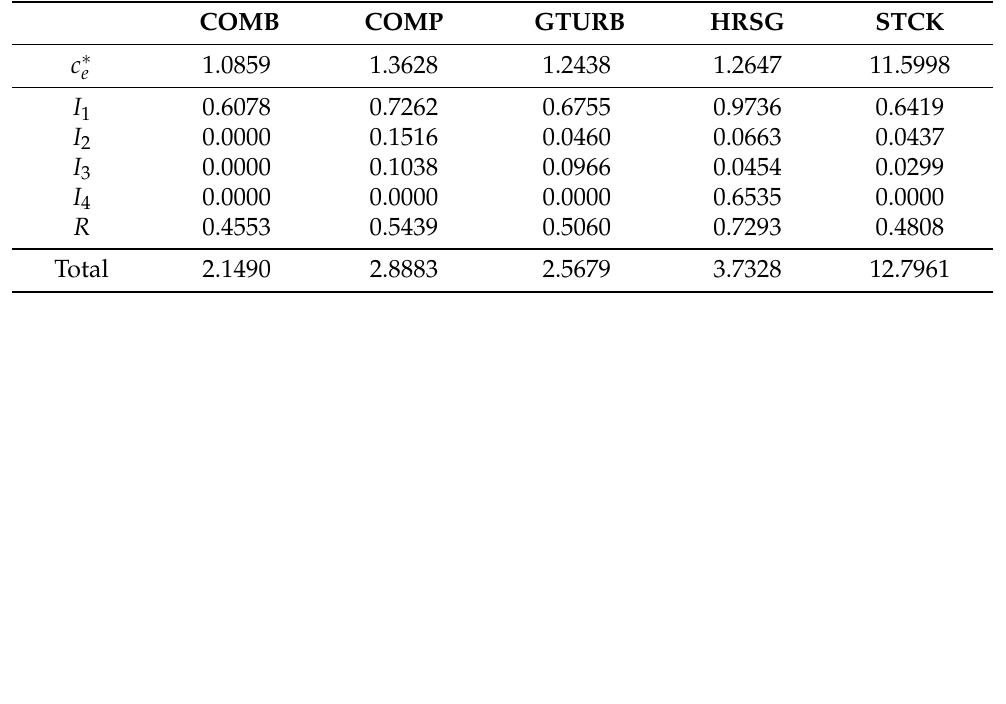
Table 11. Thermoecological production cost decomposition on TGAS Plant